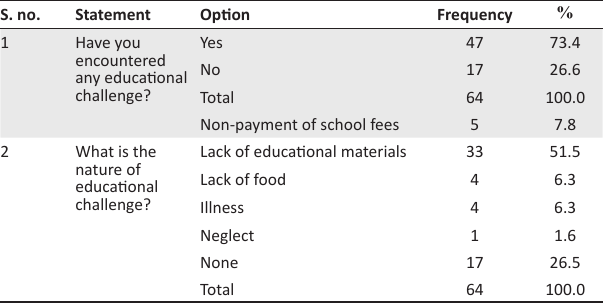
TABLE 4: Distribution of respondents’ responses on educational challenge. S.